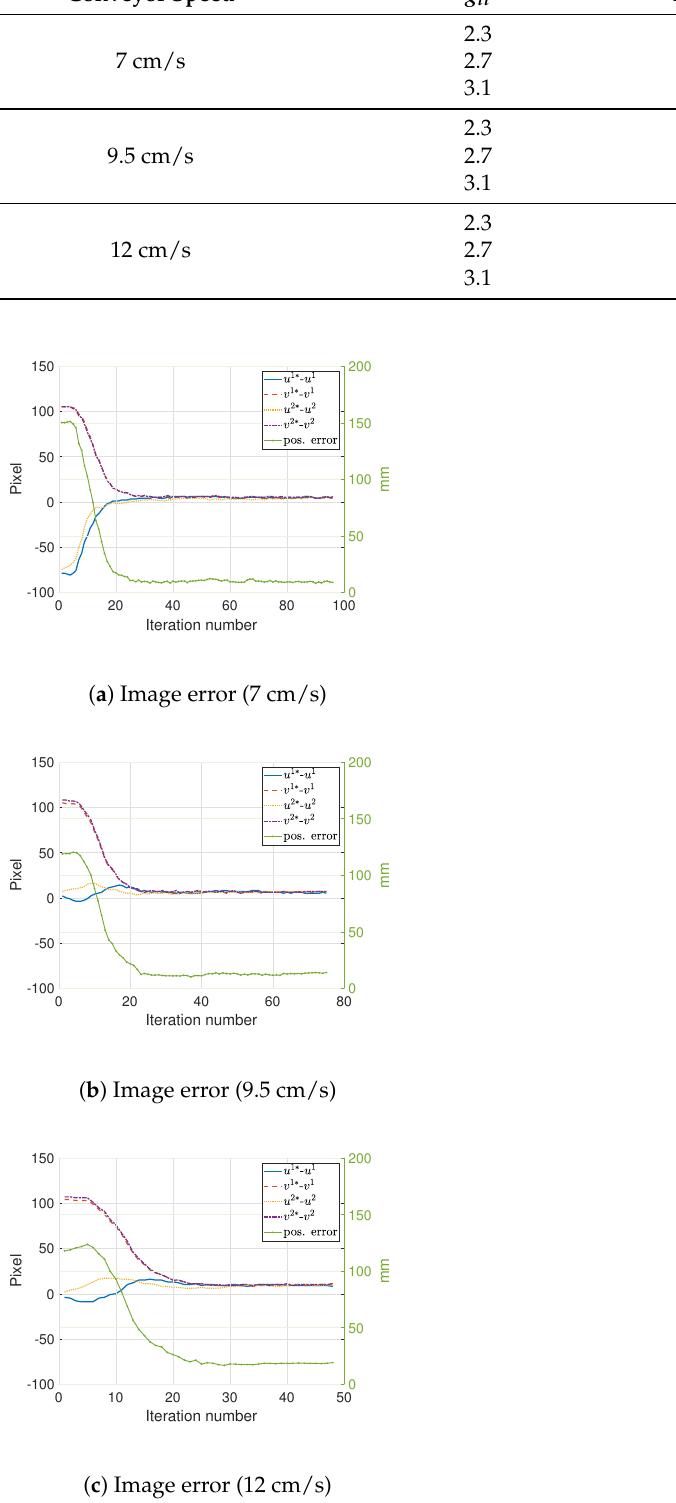
Figure 7. Tracking errors in 2D and 3D for a target in linear motion at a constant speed (the number in the parenthesis indicates the target